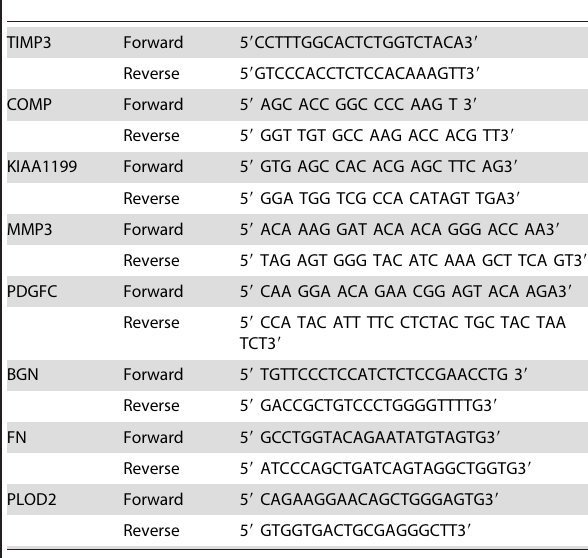
Table 1. Oligonucleotides used as primers for Real-Time Quantitative